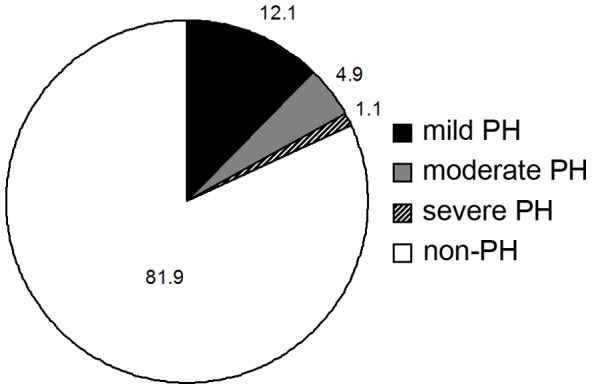
Prevalence of mild, modertate and severe PH in CKD.